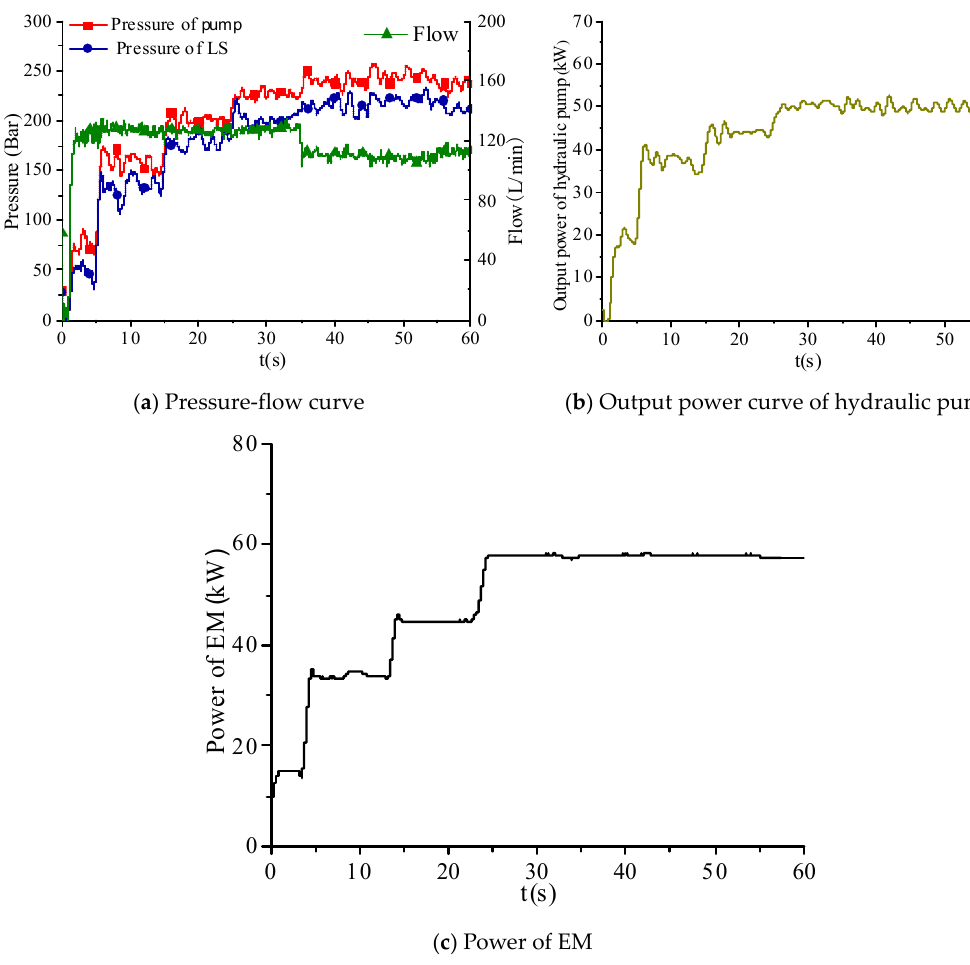
Figure 13. Test curve at 30% SOC.